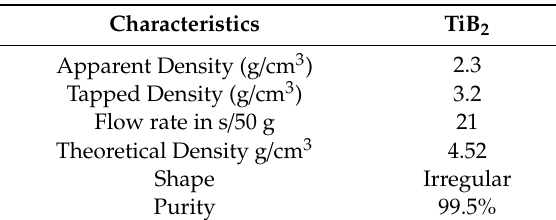
Table 2. TiB 2 powder properties.